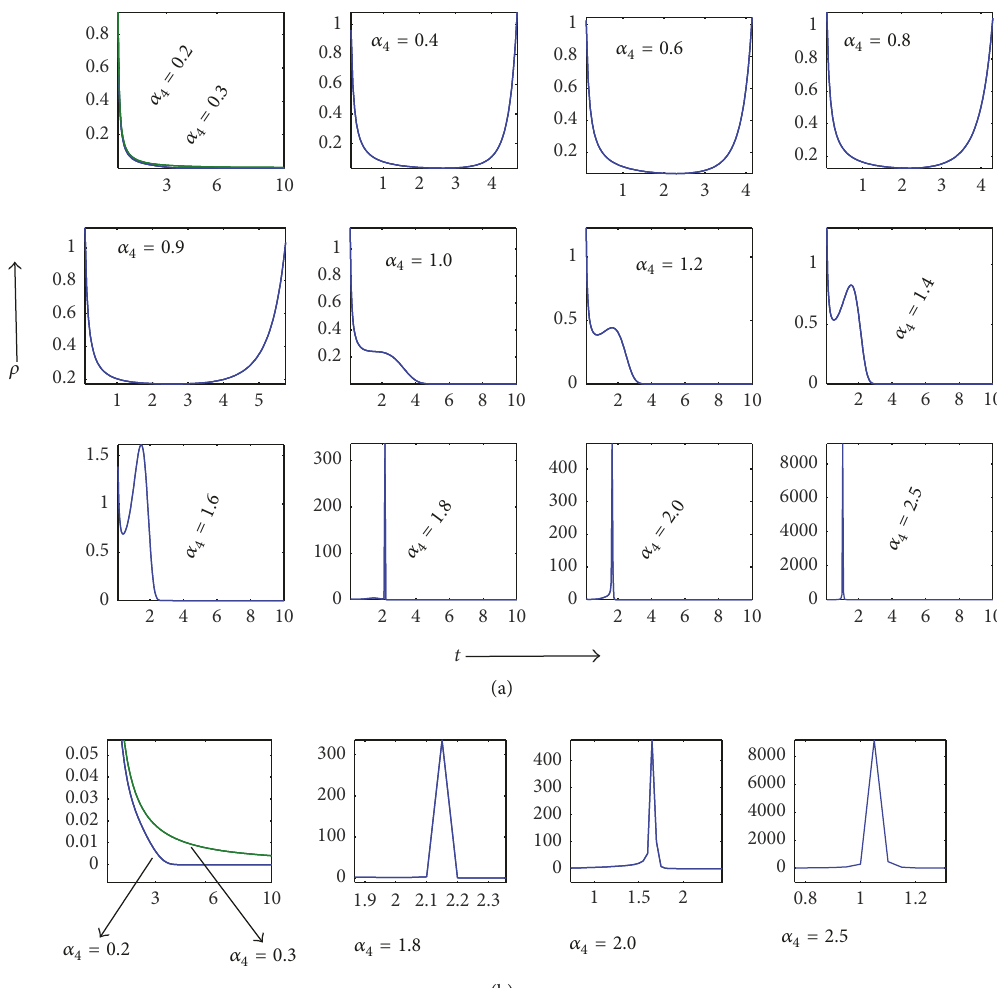
Figure 14: Variation of energy density 𝜌 against time for 𝛼 1 = 0.5 , 𝛼 5 = 0.3 , 𝜔 = 1 , 𝜙 0 = 1 , 𝑐 2 = 0.1 , and different 𝛼 4 . (b) shows the zooming of